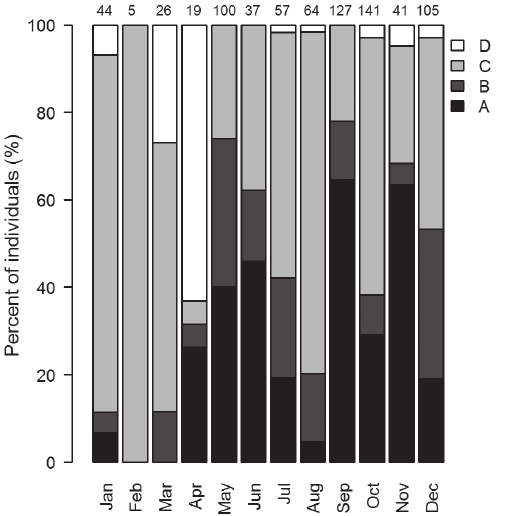
Figure 3 - Percent of individuals of Astyanax intermedius according to the stages of gonad maturation (immature/juveniles - A, maturing - B, fully mature - C and spent - D) in Ribeirão Grande stream. Numbers above bars represent the total of individuals captured per